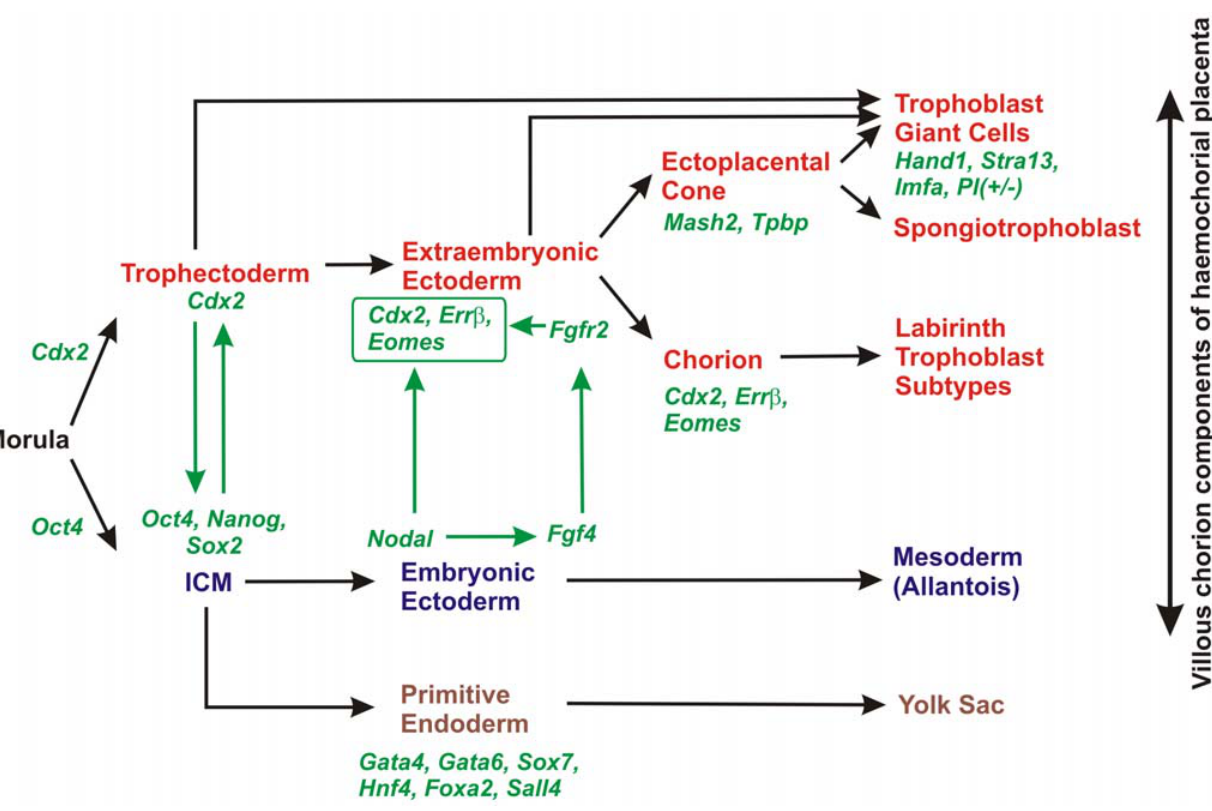
Figure 1. Transcription factor network regulating the development of ICM- and trophectoderm-derived tissues in mouse. From [2] with modifications.